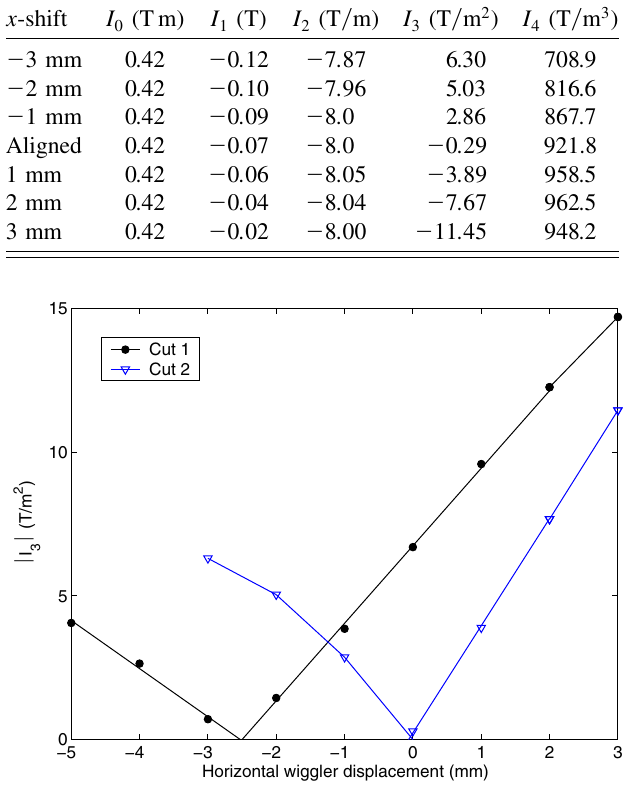
FIG. 20. (Color) Third order term of the field expansion as a FIG. 19. (Color) Absolute value of I in the central semiperiod function of the longitudinal axis for the semiperiods at positive z . 3 as a function of the horizontal beam-wiggler misalignment in In the graph for the full poles z (cid:3) 0 m corresponds to their z (cid:3) (cid:6) 0 : 16 m indicates the case the magnetic axis is displaced of (cid:8) 1 cm (Cut 1) and center, whereas for the half pole HC 2 end of the semiperiod of the previous full pole FC 5